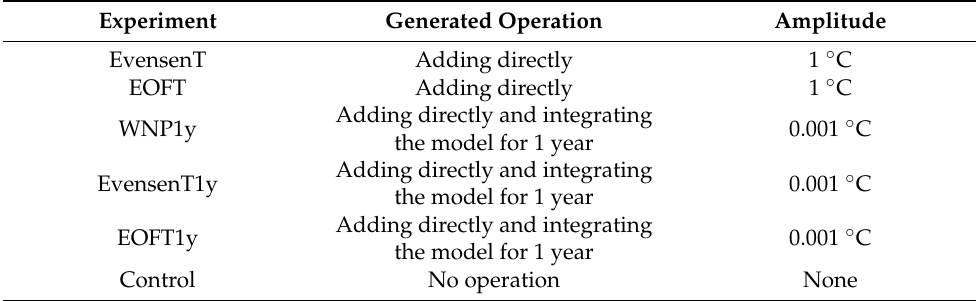
Table 2. Experiment